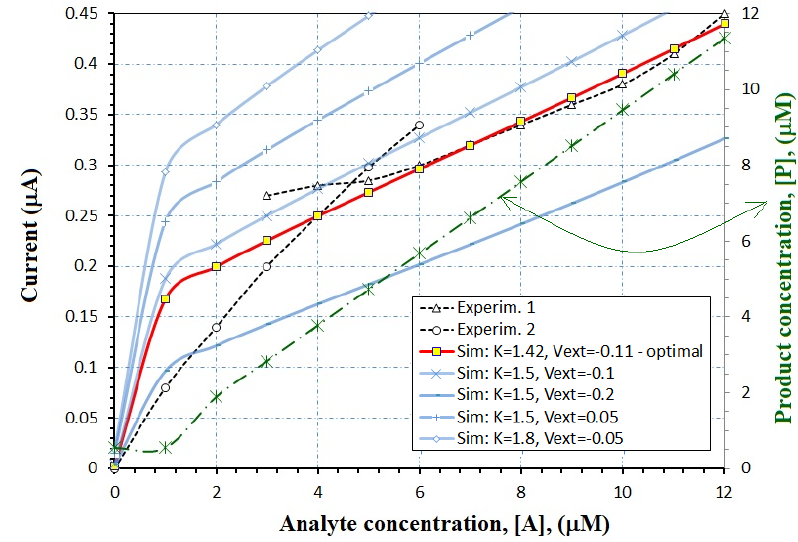
Figure 8. Analytical models are compared with experimental points from an enzymatic biosensor reported in [28]; the aspect factor K is expressed in mA/V 2 and the voltage V ext is expressed in V. Adapted from [28].